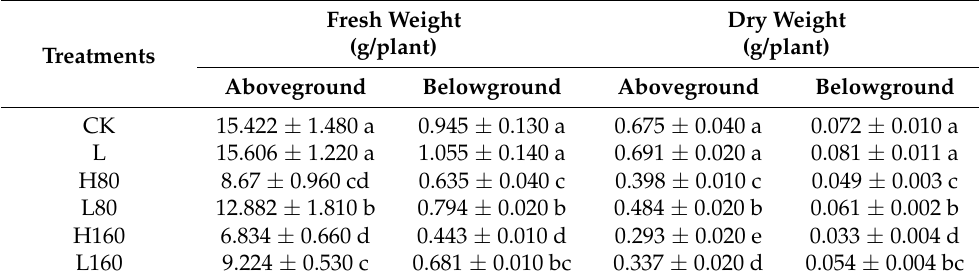
Table 2. Effects of low R:FR ratio on growth of pakchoi with excessive nitrate stress.